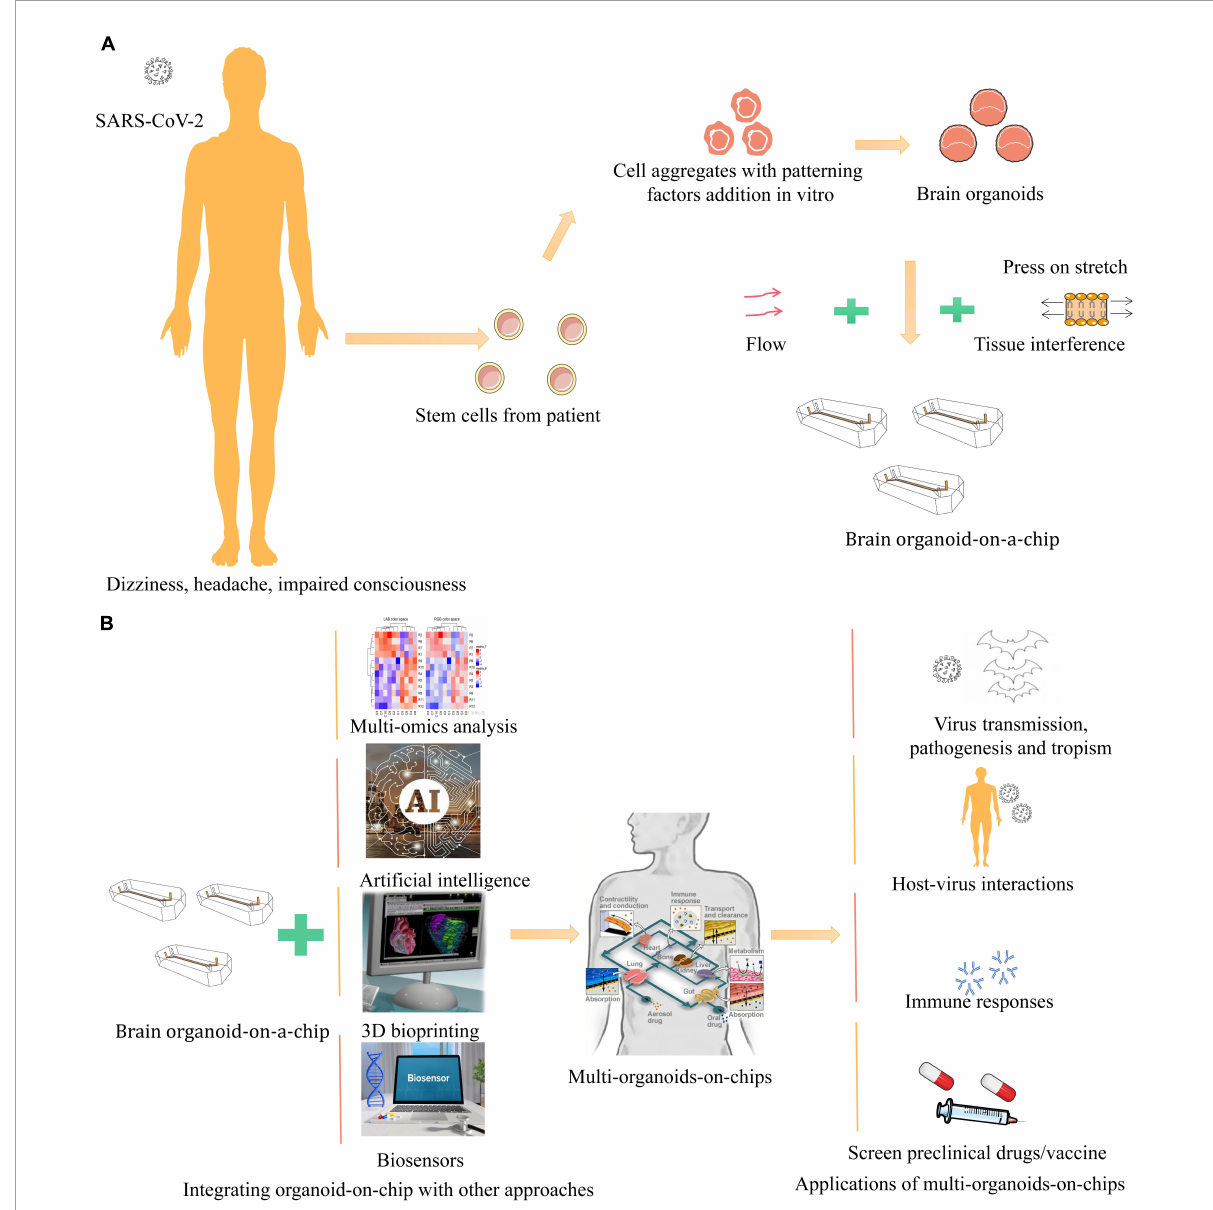
FIGURE1 Schematic illustration of in vitro human organoid models for COVID-19 research. (A) COVID-19, clinically presents a wide spectrum of neurological complications, such as dizziness, headache, impaired consciousness (Blanco et al., 2020). Brain organoids are derived from human stem cells and aggregated with patterning factors addition in vitro (Chen et al., 2021). With fluid flow, stretch, and tissue interface to mimic cellular microenvironment on a bioengineered microfluidic cell culture device, recapitulating the brain organoid-on-a-chip (Park et al., 2019). (B) Integrating brain organoid and other organoids with other approaches like multi-omics, biosensors, 3D bioprinting, and artificial intelligence to generate multi-organoid-on-chips to provide new pathway for virus, which physiologically relevant model systems can be applied to study SARS-CoV-2 virus transmission, pathogenesis and tropism, host-virus interactions, immune responses, and screen preclinical drugs and vaccine (Sang et al., 2021; Wang et al.,